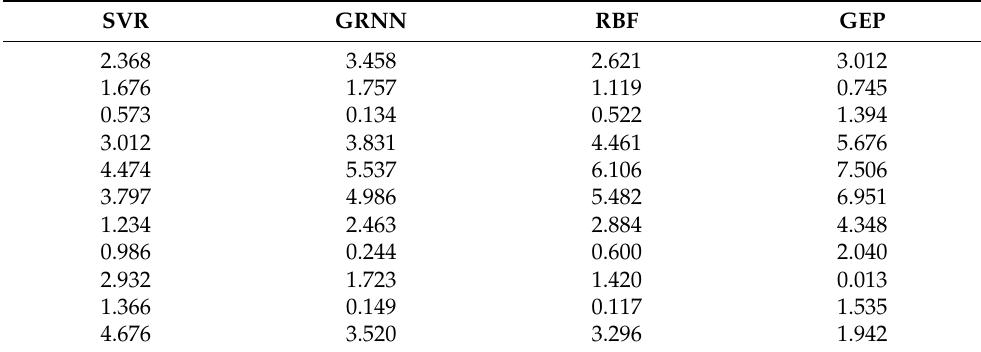
Table 4 contains the absolute percentage error in the AI models on the Test sets. Table 4. Absolute % error in AI models on the Test